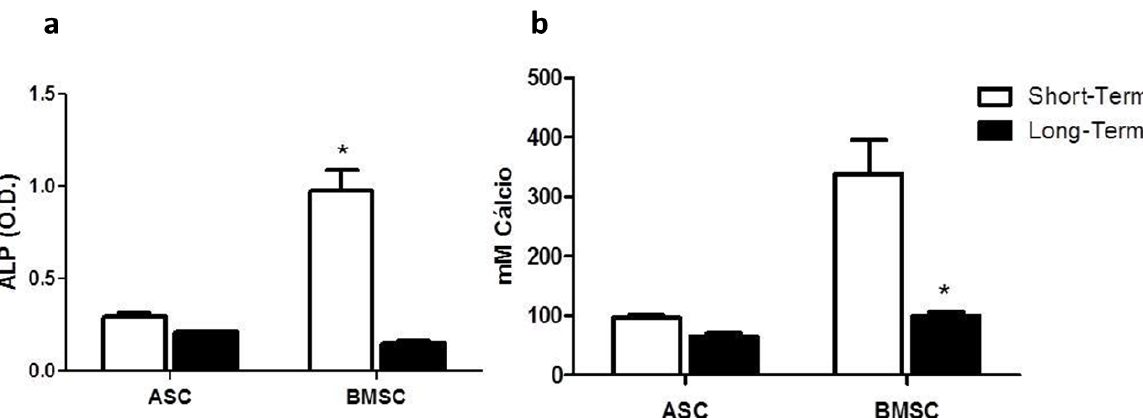
Figure 5. Quantification of the mineralized calcium matrix and indirect analysis of ALP ASC and BMSC in short and long-term. a) Analysis of ALP levels in ASC and BMSC. b) Calcium levels expressed in mM in ASC and BMSC after maintenance in inductive medium for 14 days. Data is presented as mean ± S.D. * p <0.05 (n =